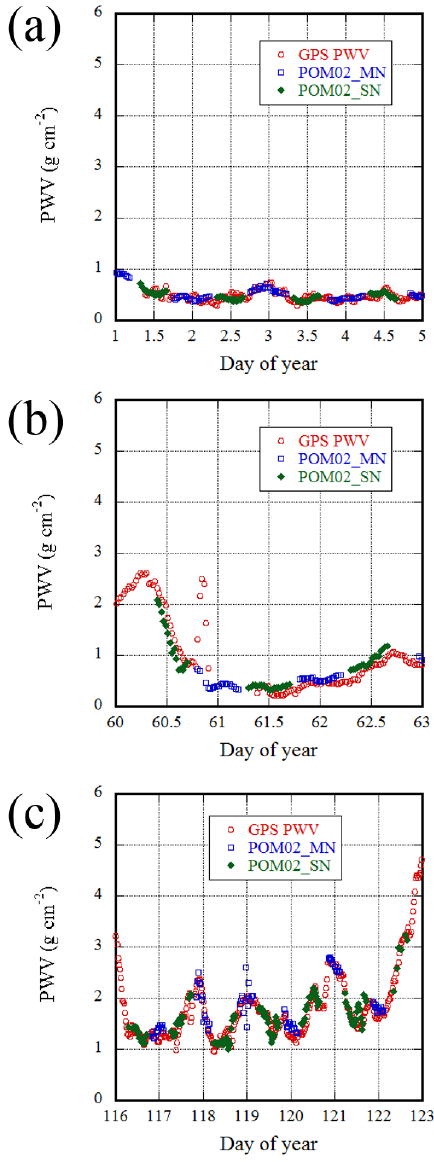
Figure 13. Examples of time series of GPS (red), POM-02 day- time (green), and nighttime (blue) corrected precipitable water va- por. The phase angles ( g ) during the measurement periods were (a) g = − 21 . 863 to 35.881 ◦ , (b) g = − 19 . 150 to 21.573 ◦ , and (c) g = − 55 . 145 to 30.611 ◦